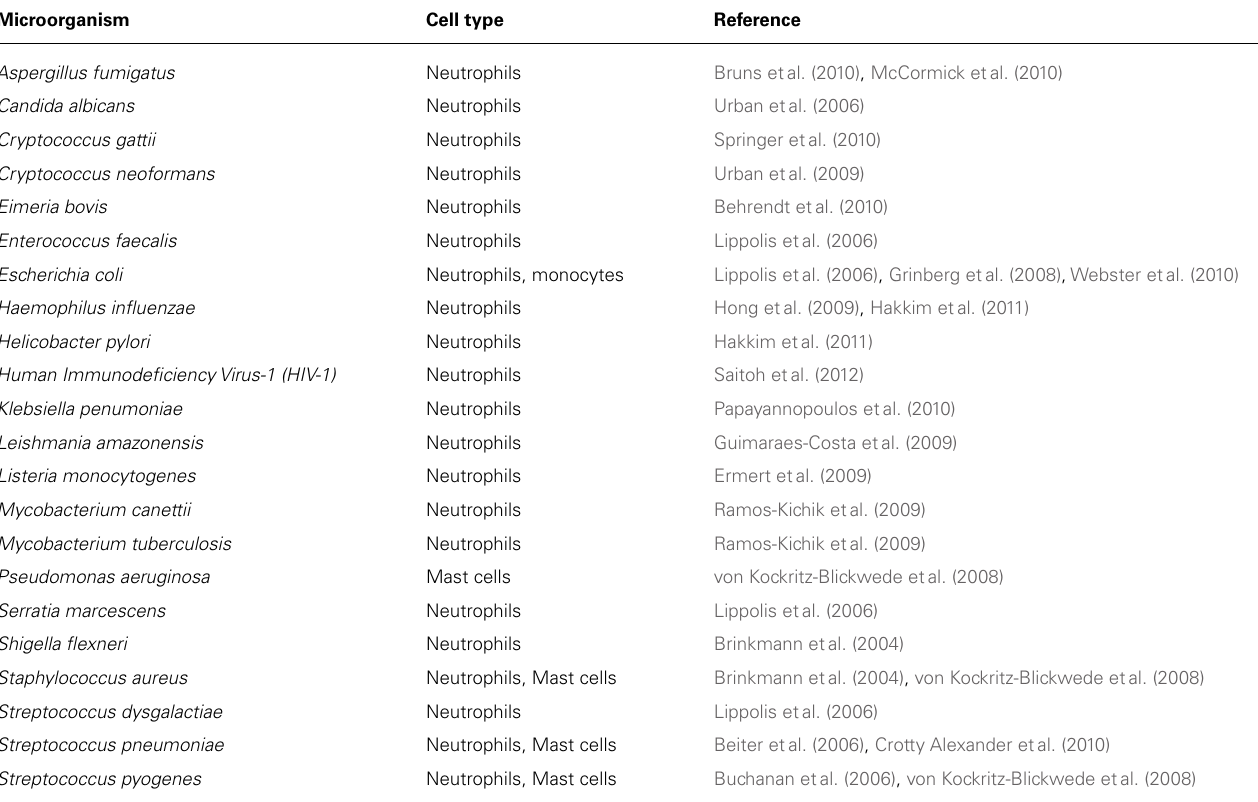
Table 3 | Microorganisms able to trigger the release of ETs by specific cell types.